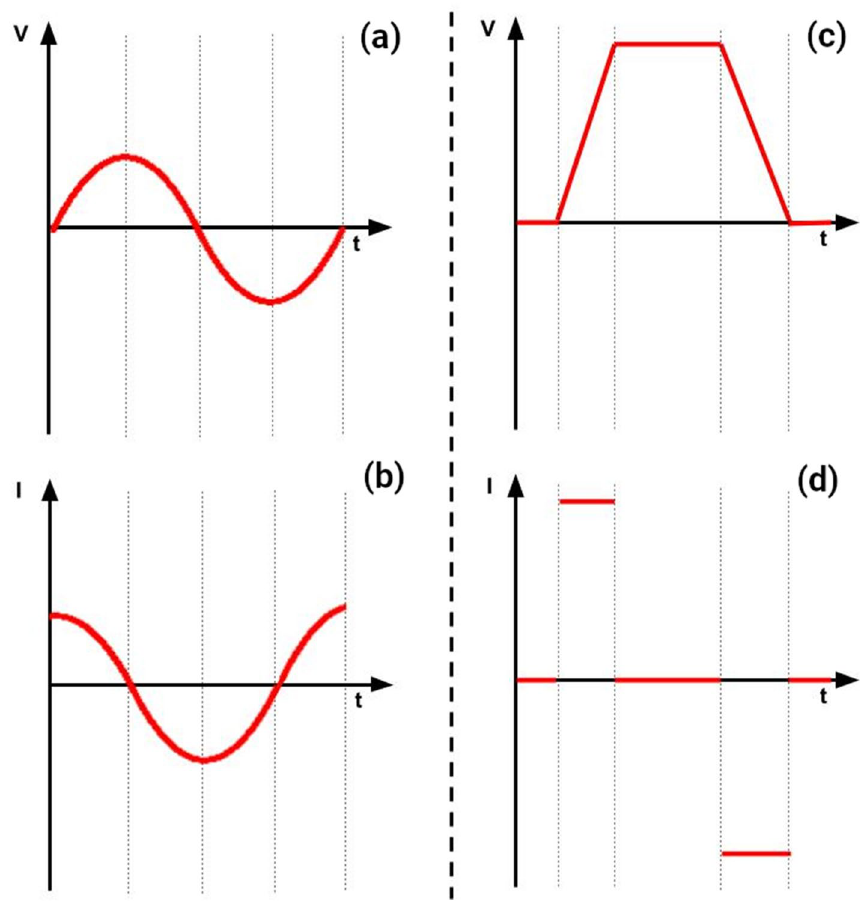
Figure 2. Voltage/current waveforms for a purely capacitive circuit. For an input sinewave voltage ( a ), the resulting current waveform is given by ( b ). For an input trapezoidal voltage ( c ), the resulting current waveform in the circuit is ( d